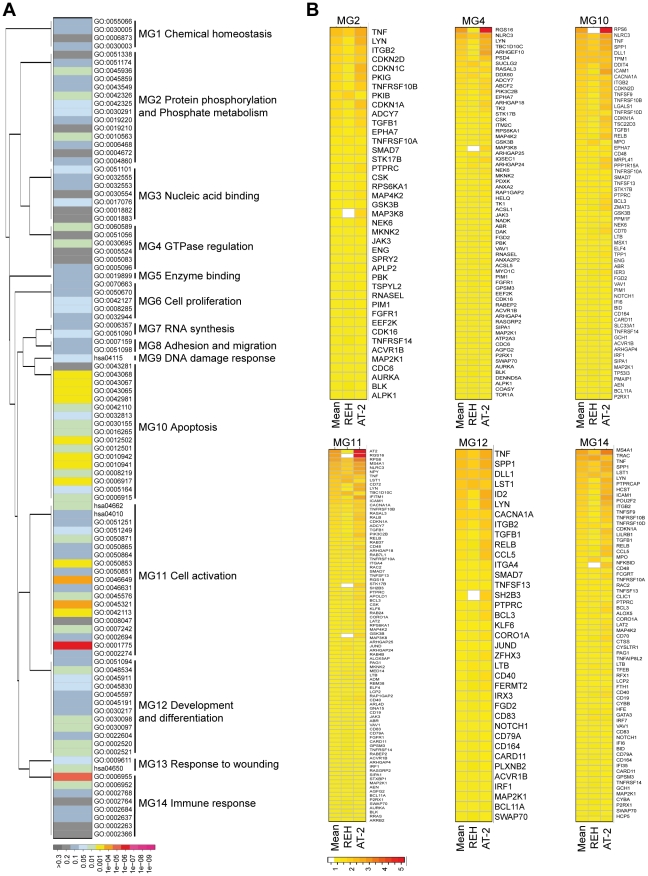
Meta-groups of functional annotations for up-regulated genes upon E/R KD.Meta-groups were curated based on gene-clustering of annotation terms. A: Top 100 annotation terms from KD-UP genes, their P-values and their affiliation to meta-groups. Similarity of the meta-groups was based on the number of shared genes. For distance calculations between the meta-groups genes from all contributing terms were taken together. B: Change in expression of individual genes in meta-groups that contain significant annotation terms. The color code at the bottom of the figure indicates the extent of log2-fold changes in gene expression.